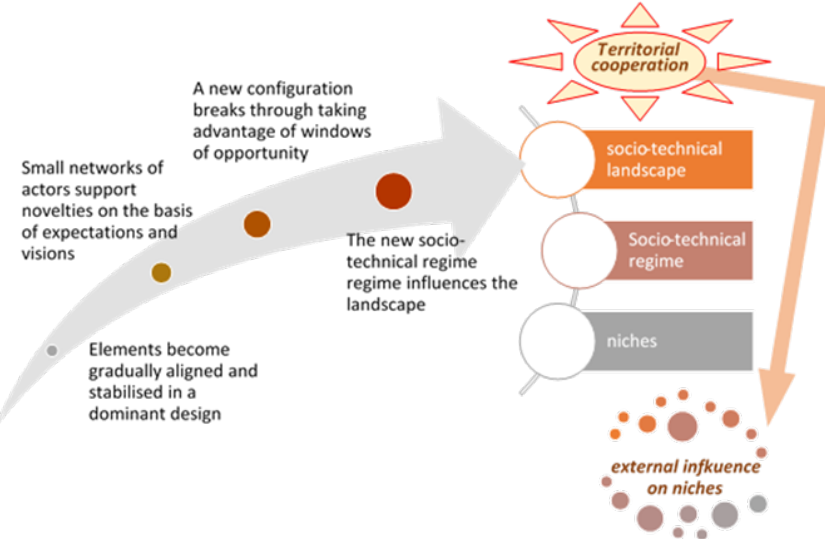
Figure 3. Territorial cooperation as the potential stimulator of sustainable transition. Source: own study based on [22].